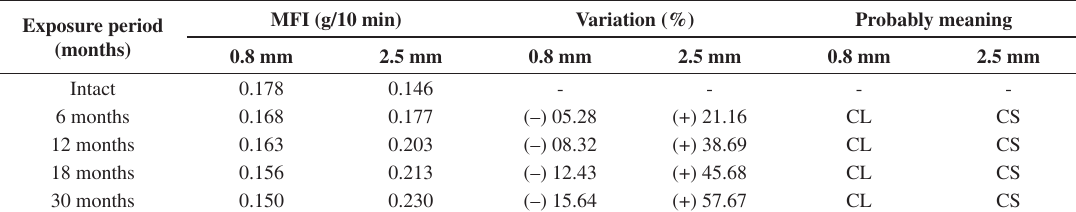
Figure 3. Effects of weathering on tear and puncture resistances after 30 months of outdoor Table 2. Results of MFI tests after weathering exposure.